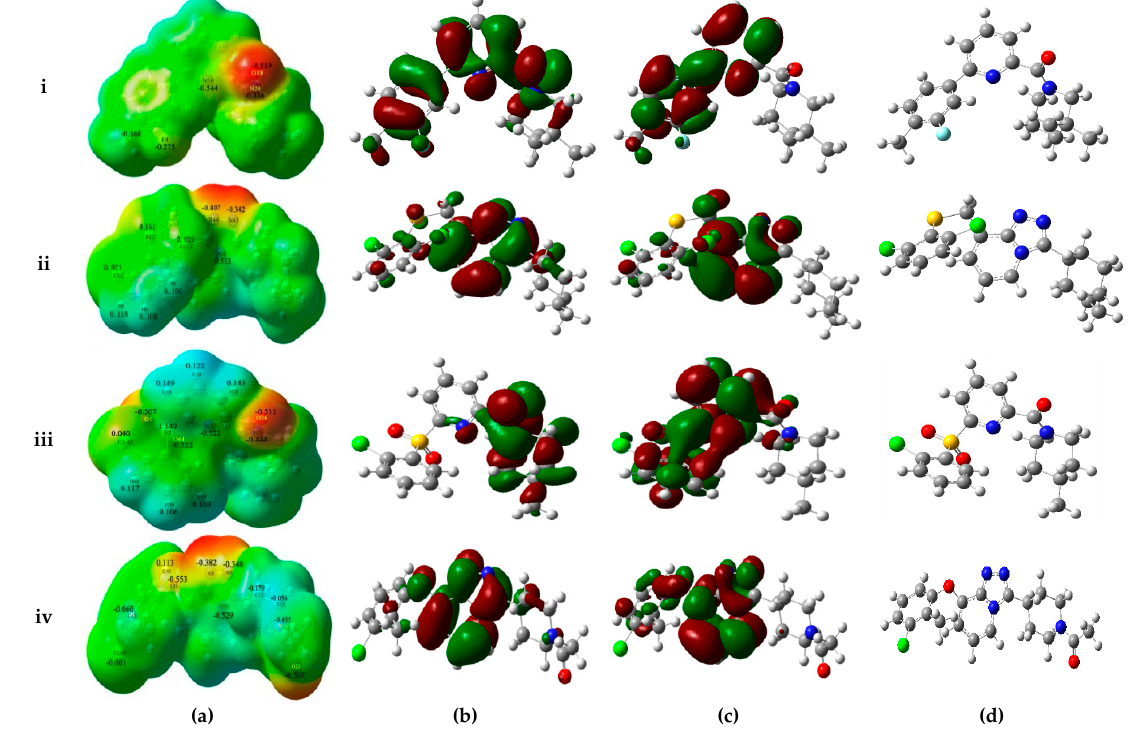
Figure 4. ( a ) MESP superimposed onto a surface of constant density and Mulliken atomic charges mapped onto the active compounds ( 1 and 32 ) and low active compounds ( 14 and 39 ) (i, ii, iii, and iv); ( b ) HOMOs; ( c ) LUMOs orbitals with B3LYP/6-31g(d,p); ( d ) the structures of the active compounds ( 1 and 32 ) and low active compounds ( 14 and 39 ). The variation in MESP from positive to negative is shown in red to blue scale.